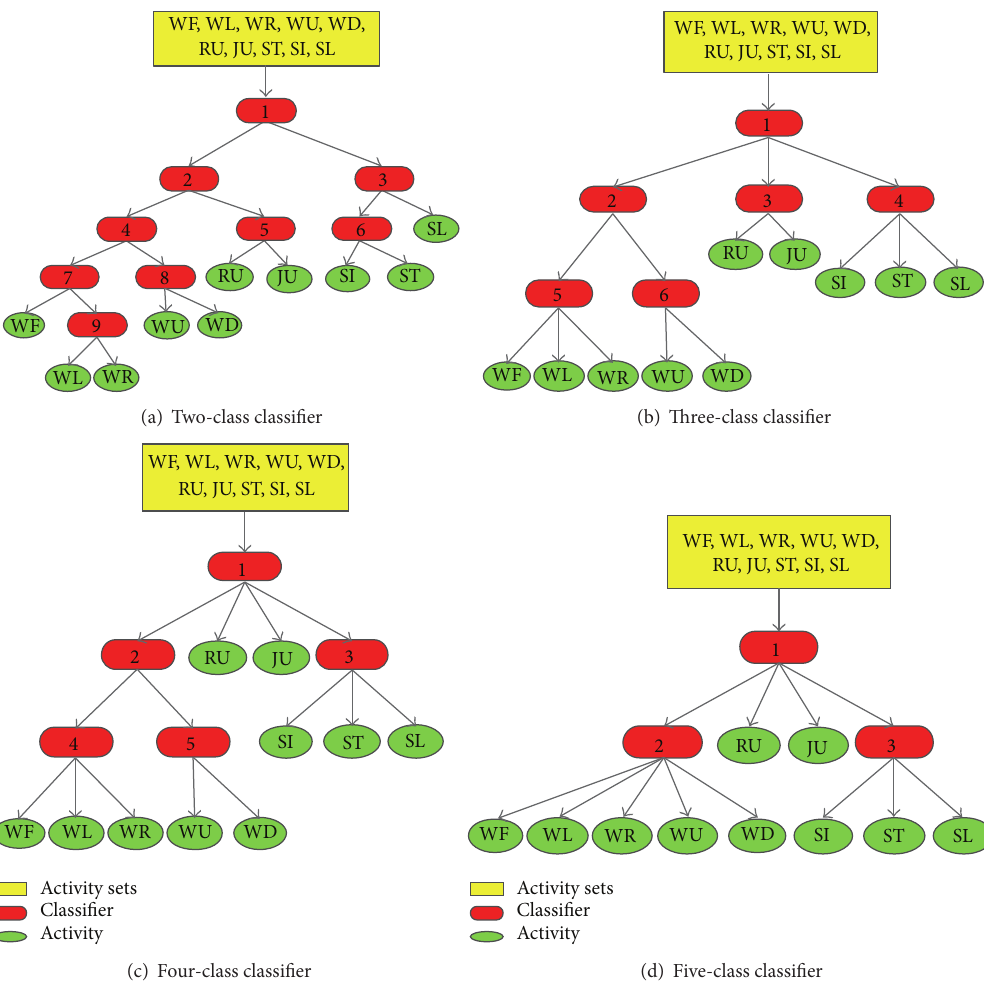
Figure 1: Structure of the hierarchical classification framework.